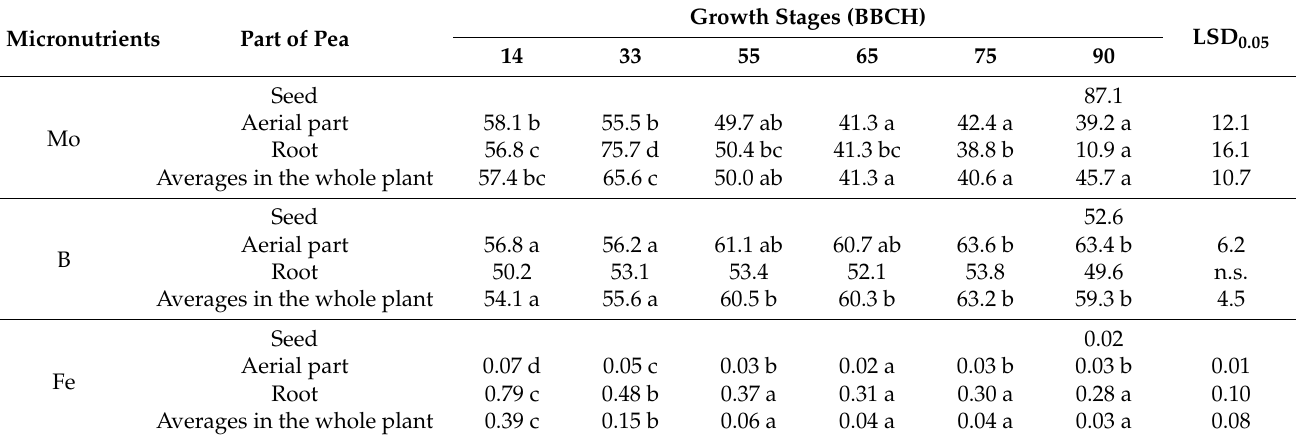
Table 7. Bioaccumulation factors of Mo, B, and Fe in successive growth stages of a pea.